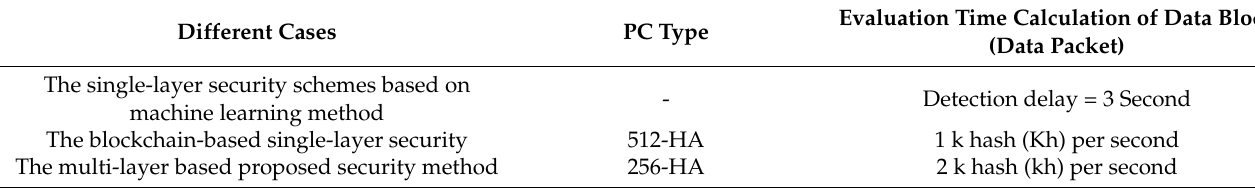
Figure 16. Assessing the double-layer security scheme. Table 4. Comparison among cases based on calculated hash